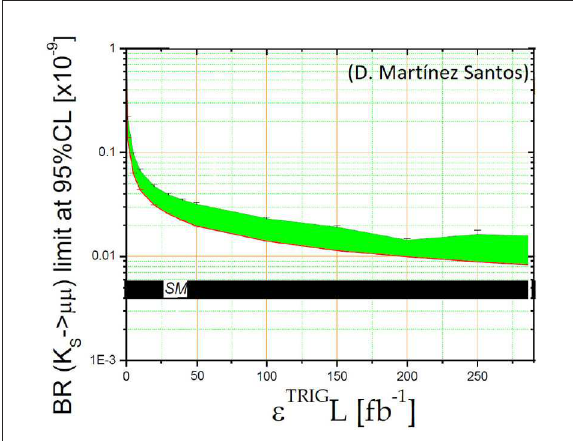
FIGURE11 Sensitivity (green band) to the K 0 S function of the trigger efficiency prediction is shown in black (Santos,